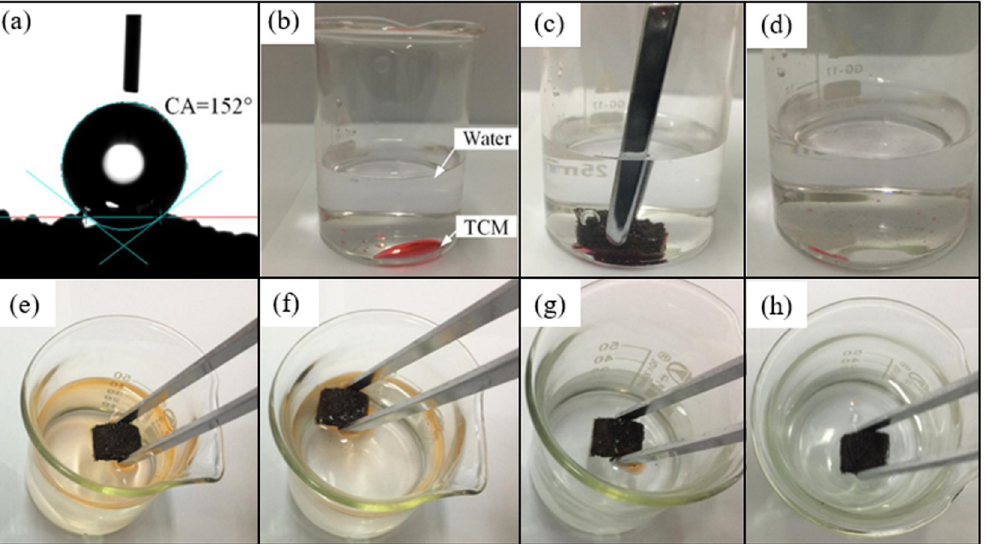
Figure 5: ( a ) Water CA test of the HMS sample after surface modi fi cation showing a 152° CA with water and a nearly 0° oil CA; ( b – d ) the process of separating TCM ( Oil - Red O dyed ) from water; ( e – h ) the process of separating n - heptane ( dyed orange ) from water; the unique hierarchical structure of the HMS sample shows its superior performance for oil/water separation under both in - water and on - the - surface - of - water